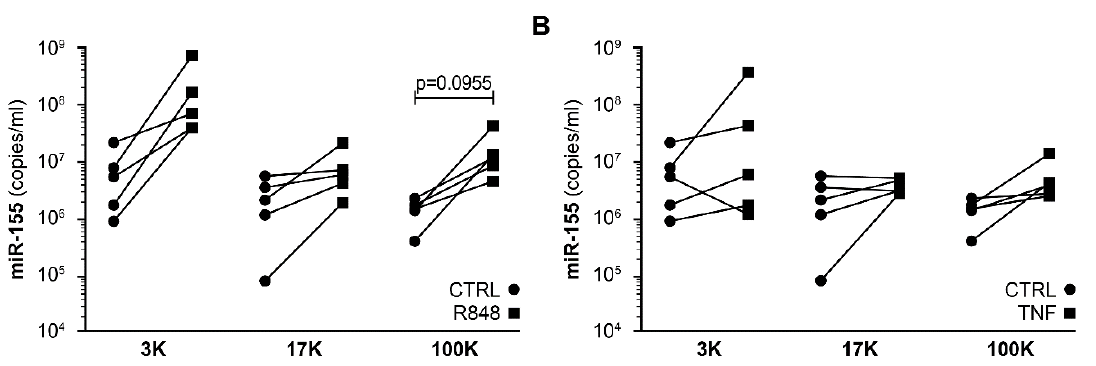
Figure 4. Stimulated PBMCs release miR-155-rich large EVs.PBMCs freshly isolated from HIV-negative donors (n = 5) were incubated with ( A ) R848 (1 µ g/mL) and ( B ) TNF (100 ng/mL) for 24 h. Supernatants were centrifuged sequentially at 3000 × g (3K), 17,000 × g (17K) and 100,000 × g (100K). Mature miR-155 was quantified by RT-qPCR, using a standard curve produced from synthetic miR-155. Each dot represents one donor. The significant difference is based on parametric paired t-tests to compare the activated condition (R848 or TNF) versus the control condition.